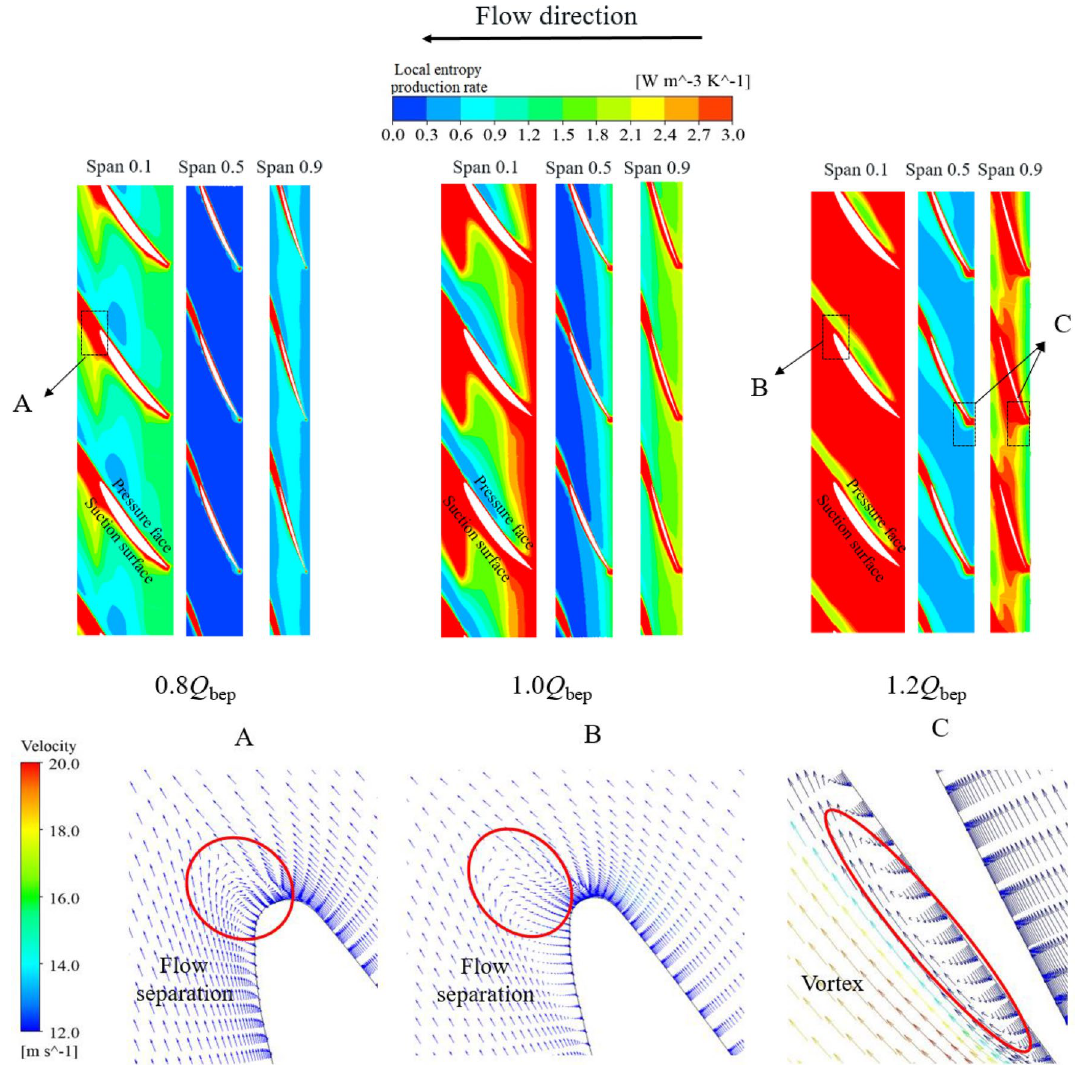
Figure 13. Entropy production rate distribution of different impeller spans and local velocity vector amplification